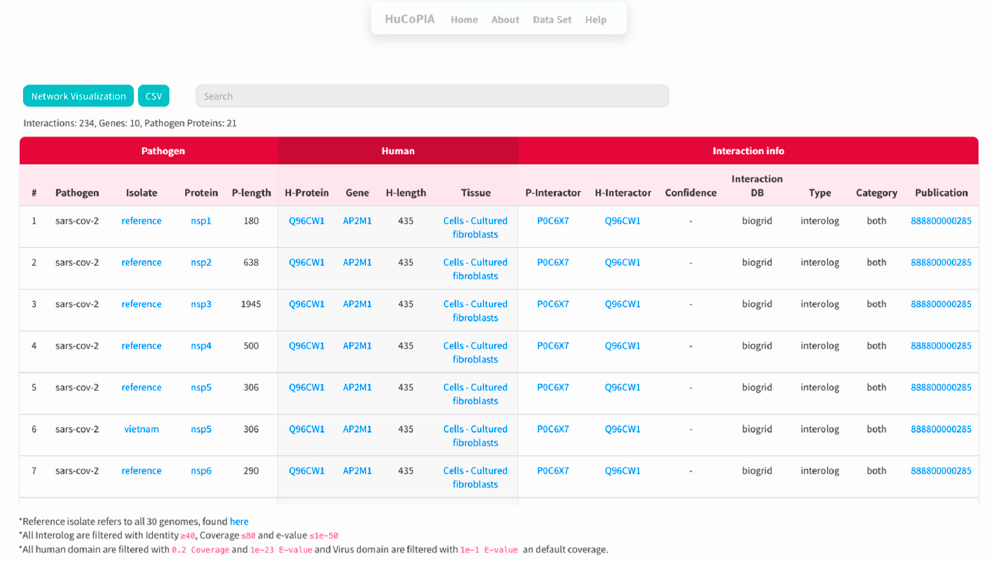
Figure 4. Network visualization of HPIs between ten genes and SARS-CoV-2.